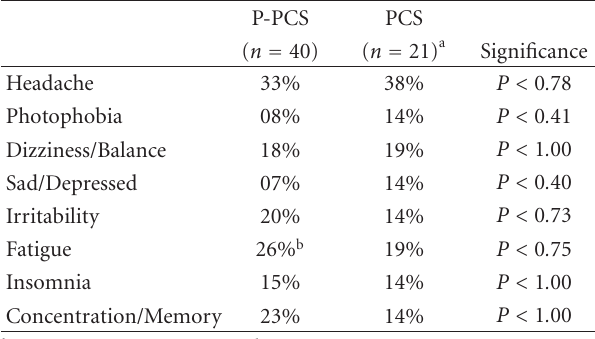
Table 3: Percent of patients with followup information ( n = 63) in P-PCS and PCS groups who endorsed individual symptoms.